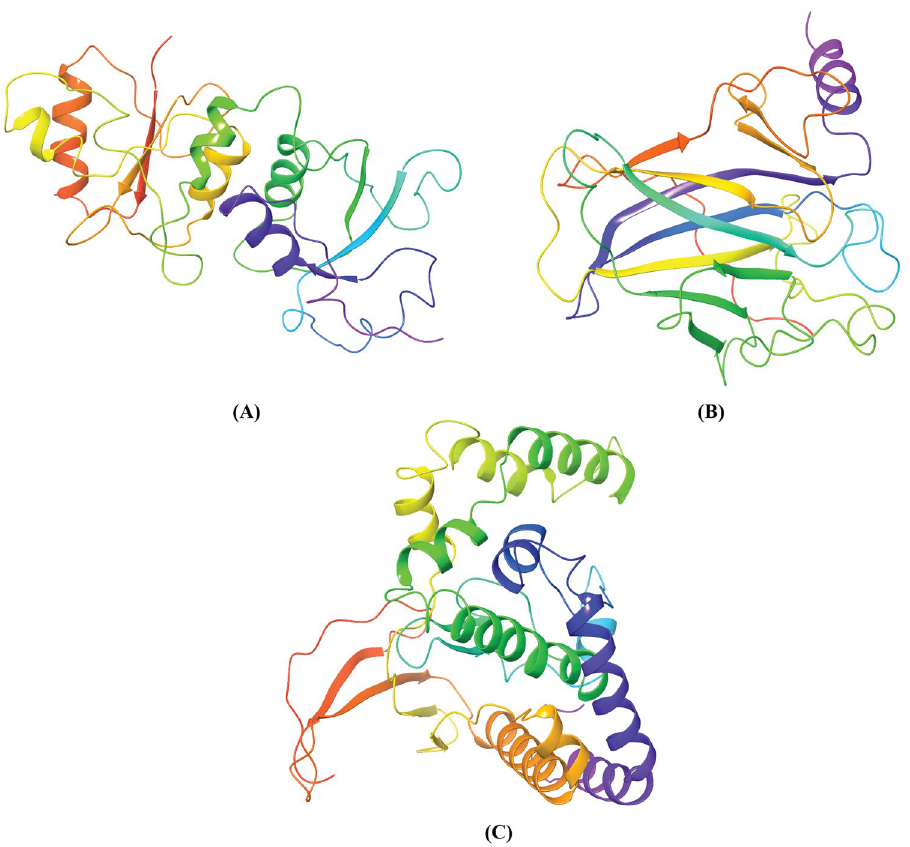
Figure 4. 3D structures of three domains from BRCA1, ATM and p53 protein. ( A ) Crystal structure of BRCT domain of BRCA1 at 3.50 Å resolution. ( B ) DNA binding domain of p53 at 1.92 Å resolution. ( C ) Modelled 3D structure of the catalytic domain of ATM. We used 5NP0 as template to model the domain.